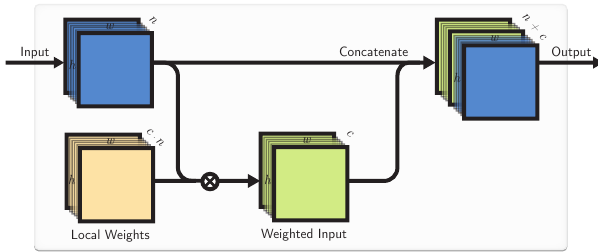
Figure 2. The proposed Local Weights (LW) block. Input (in blue) is multiplied (7) (depicted with with the input weight block (in brown), and the weighted input is further passed to the other layers of